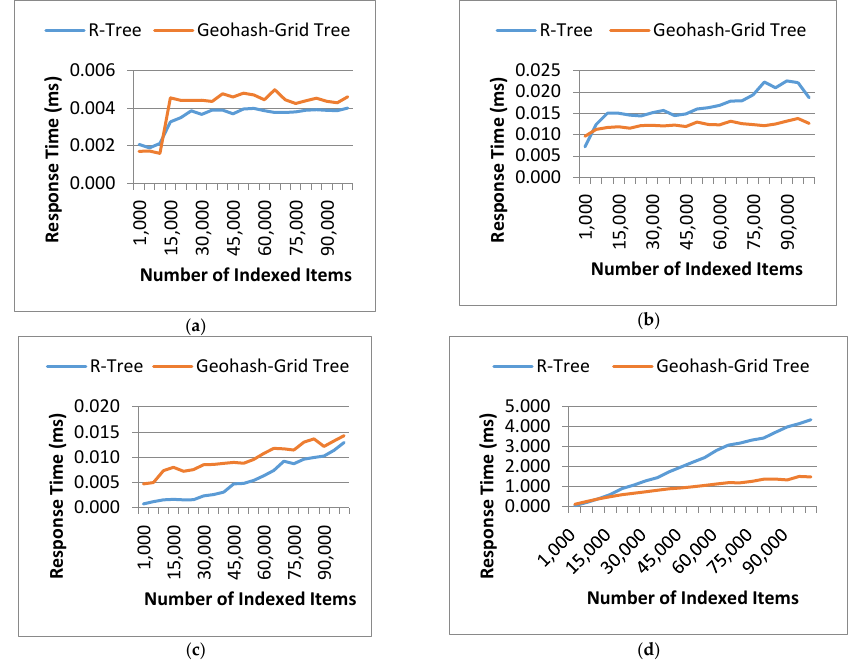
Figure 6. Tree response time: Geohash-Grid Tree and R-Tree. ( a ) Query 1: point matching in a sparse area; ( b ) Query 2: point matching in a dense area; ( c ) Query 3: range matching in a sparse area; ( d ) Query 4: range matching in a dense area.